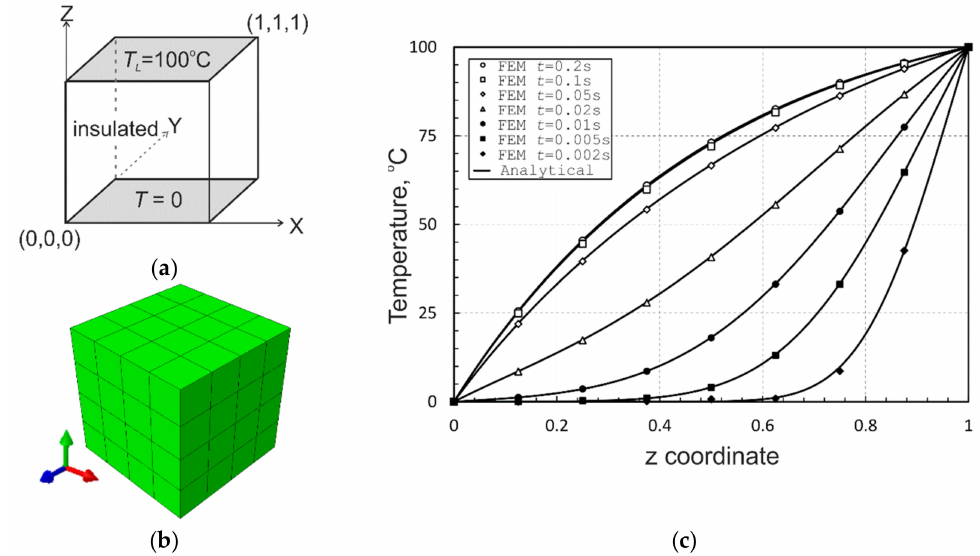
Figure 3. The FGM unit cube problem: ( a ) geometry and thermal boundary conditions; ( b ) finite element mesh; and ( c ) transient temperature profiles.